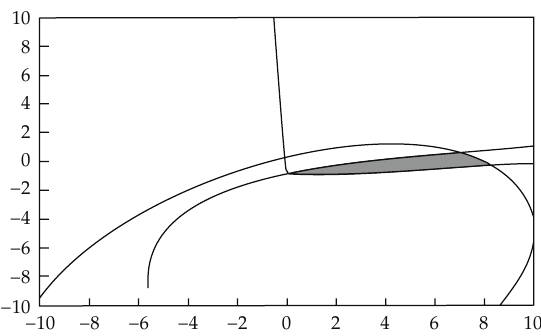
Figure 1: The feasible region S for Example